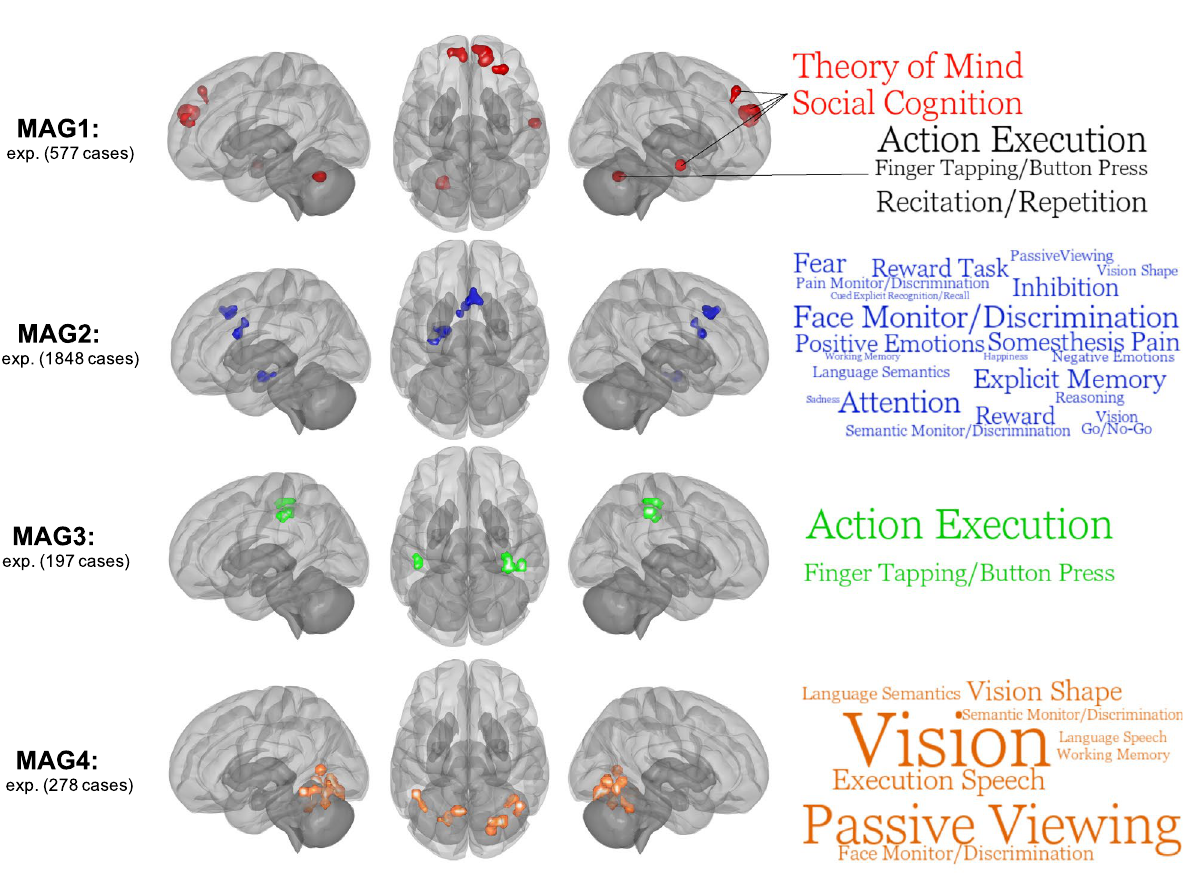
Figure 3. ALE meta-analysis on each significant meta-analytical grouping (MAGs). Images are shown for left hemisphere (lateral), superior view and right hemisphere (lateral) respectively. ALE images were thresholded at p < 0.001 at the voxel-level and pFWE > 0.05. Word clouds were generated using BrainMap database terms (Behavioral Subdomains & Paradigm). Font size represents Z-score associated with the whole MAG (all words are significant p = 0.05 with Bonferroni